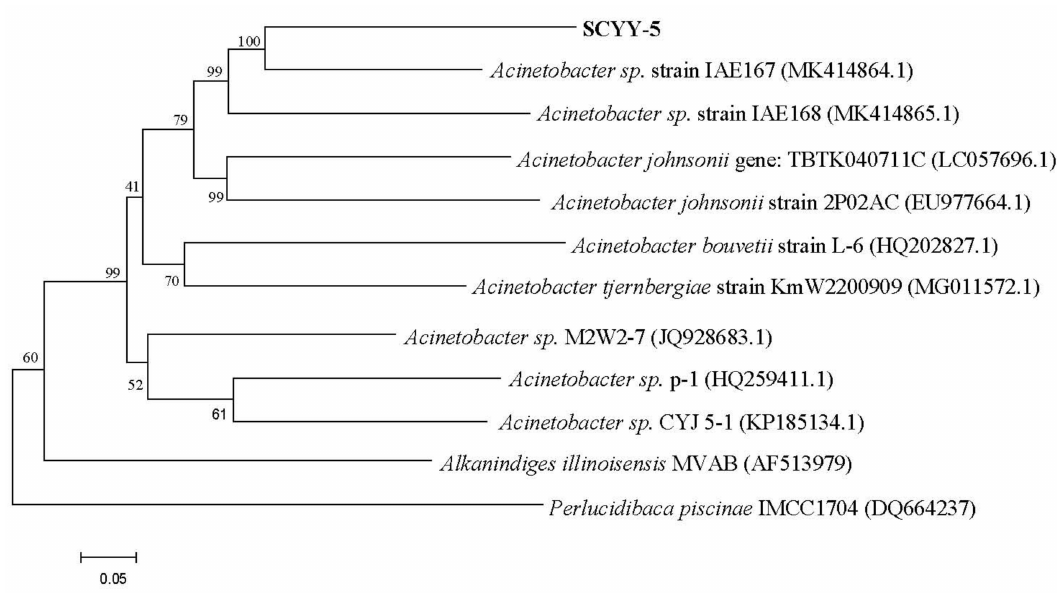
Figure 1. Phylogenetic trees of Acinetobacter sp. SCYY-5. Phylogenetic trees were constructed based on the 16S rDNA gene sequences (1241 bp) using the neighbor joining method. Phylogeny test used bootstrap method with 1000